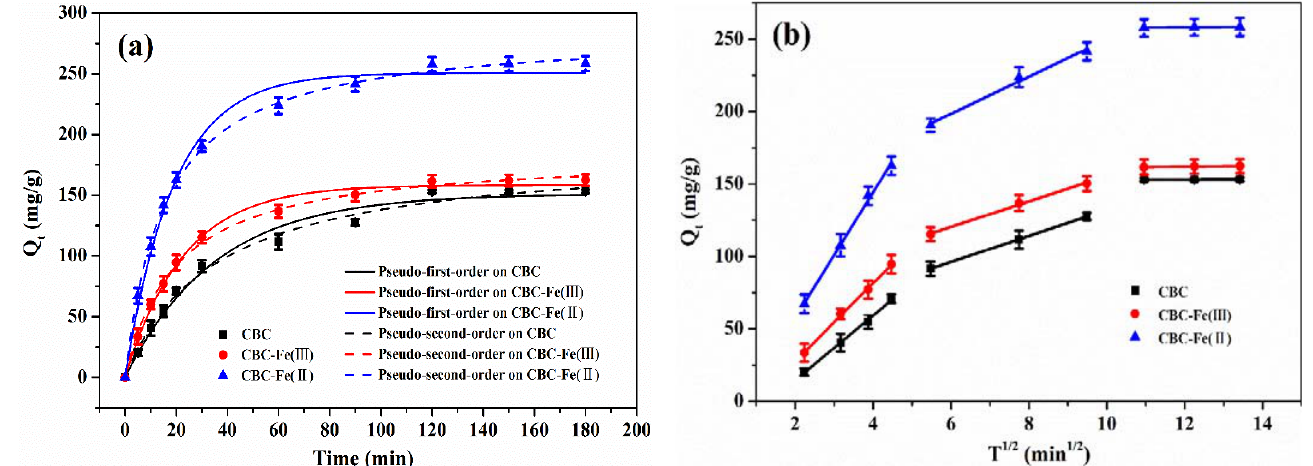
Figure 10. ( a ) Pseudo-first-order and pseudo-second-order and ( b ) intra-particle diffusion models of RhB adsorption by CBC, CBC-Fe(III) and CBC-Fe(II).